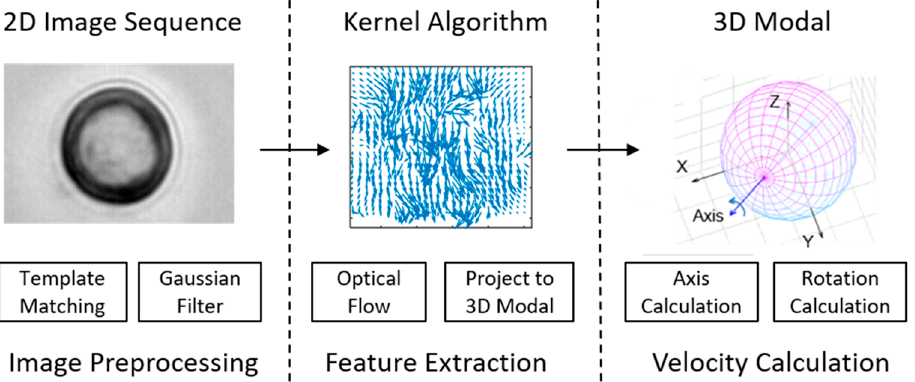
Figure 3. A flow diagram of the algorithm architecture.